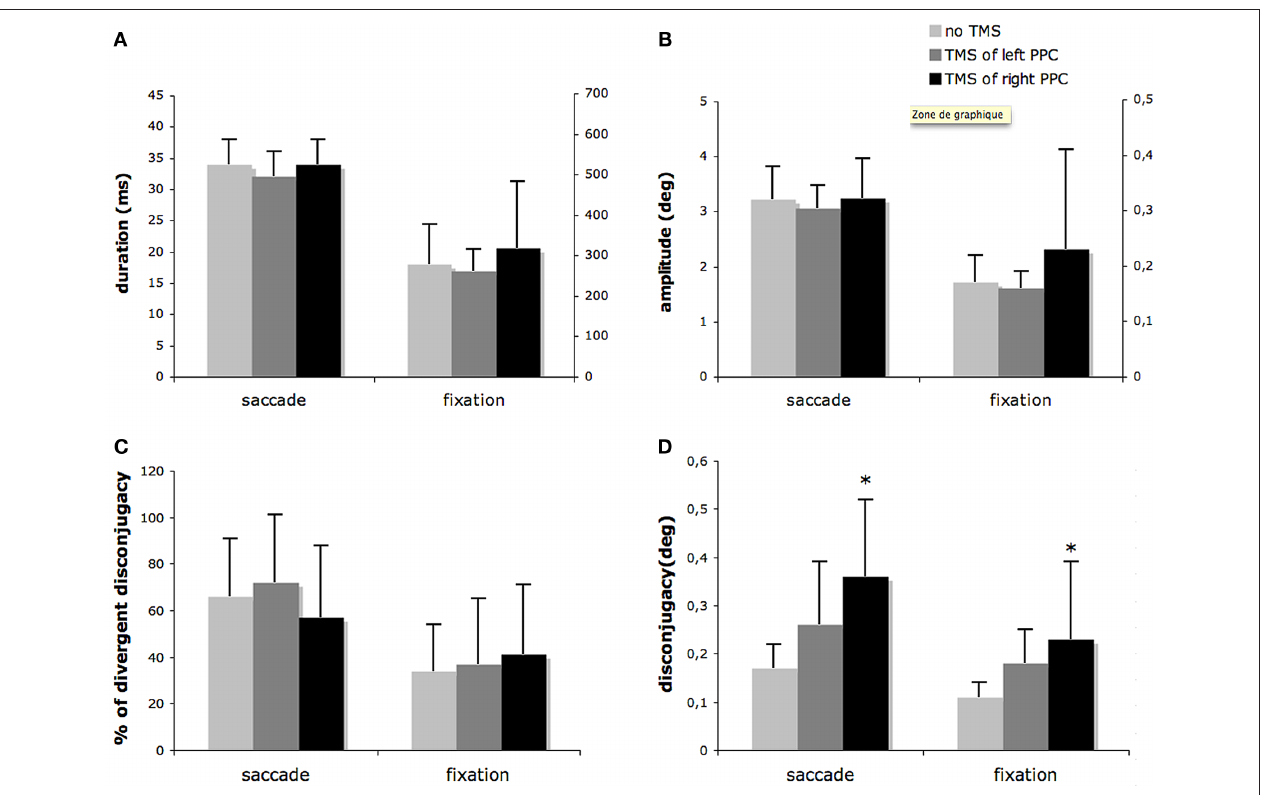
FiGure 2 | effects of single-pulse TMS on saccades and fixations. Means and SD of: (A) saccade and fixation duration; (B) saccade and fixation amplitude (in absolute value); (C) percentage of saccade with divergent disconjugacy and